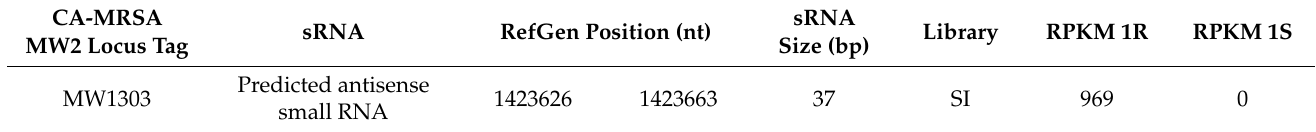
Table 2. Genome position and orientation of the MW1303 asRNA.